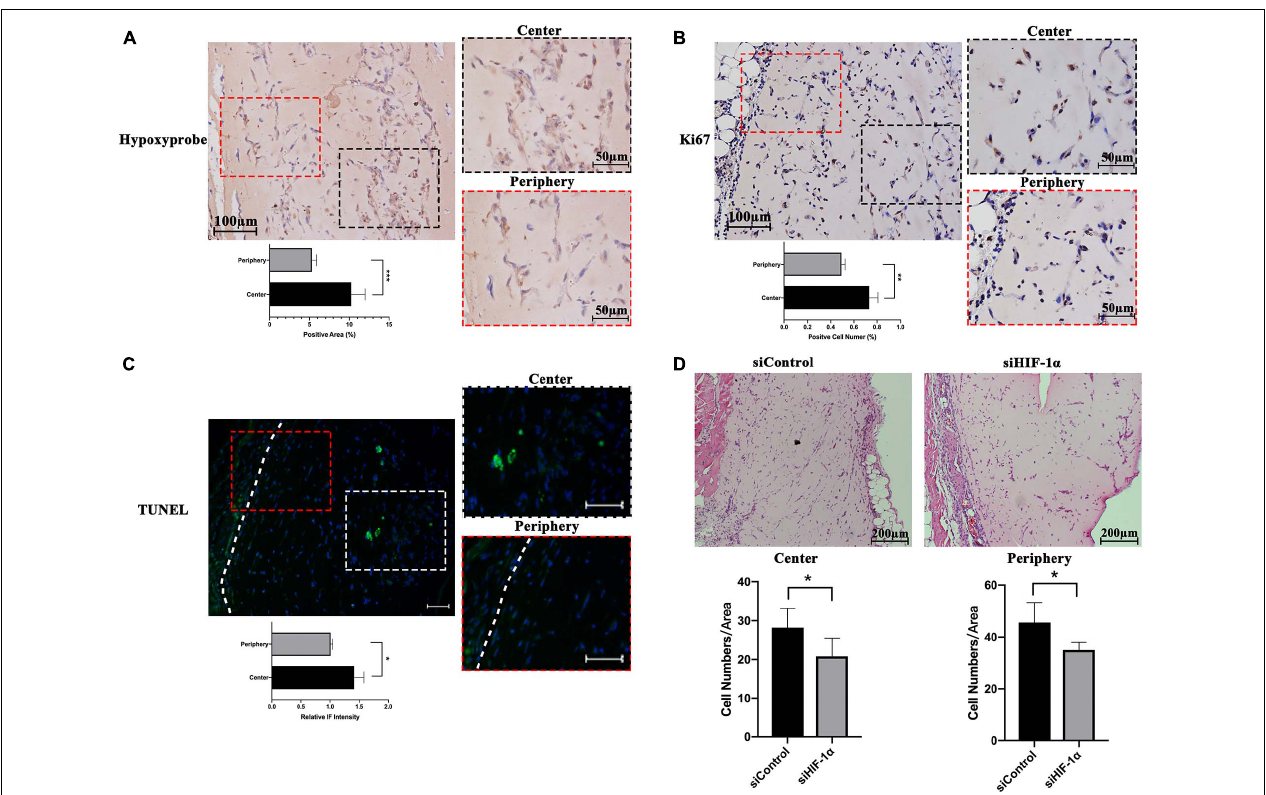
FIGURE 1 | Hypoxic status and cell survival within SHED-seeded Matrigel plugs in vivo . Immunohistochemistry for (A) Hypoxyprobe and (B) ki67, and (C) immunofluorescence for TUNEL assay in the center and the periphery of the Matrigel plug (D) . Cellularity at the center and the periphery of H&E stained Matrigel plugs of siControl and siHIF-1 α SHED after 7 days of implantation. White dotted line – the boundary between Matrigel plug and mouse tissue. * p < 0.05, ** p < 0.01, and *** p < 0.001. Scale bar: 10 × = 200 µ m, 20 × = 100 µ m, 50 × = 50 µ m, and IF = 50 µ